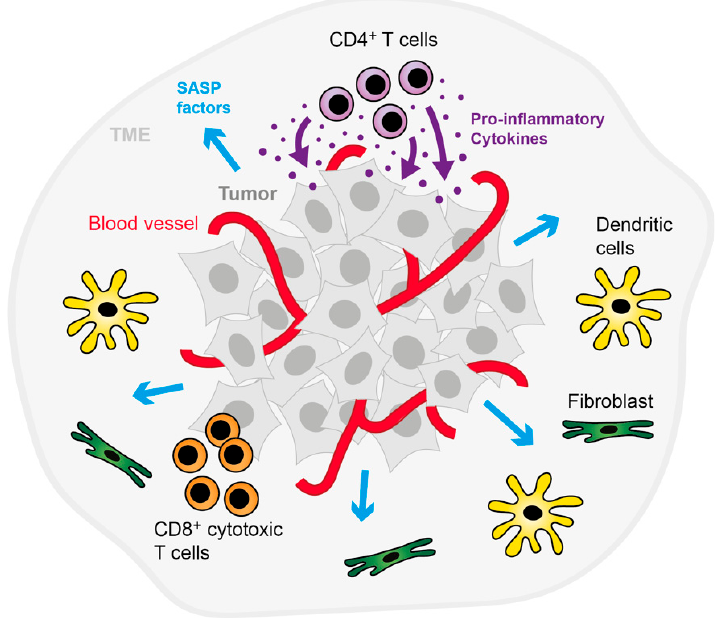
Figure 3. Cytotoxic and non-cytotoxic tumor immune control. The cartoon summarizes the control of a tumor by non-toxic mechanisms executed by CD4 + T cells that secrete pro-inflammatory cytokines (upper part of the cartoon) or toxic mechanisms executed by tumor-infiltrating cytotoxic CD8 + T cells (lower part of the cartoon). Abbreviations: SASP, senescence-associated secretory phenotype; TME, tumor microenvironment.